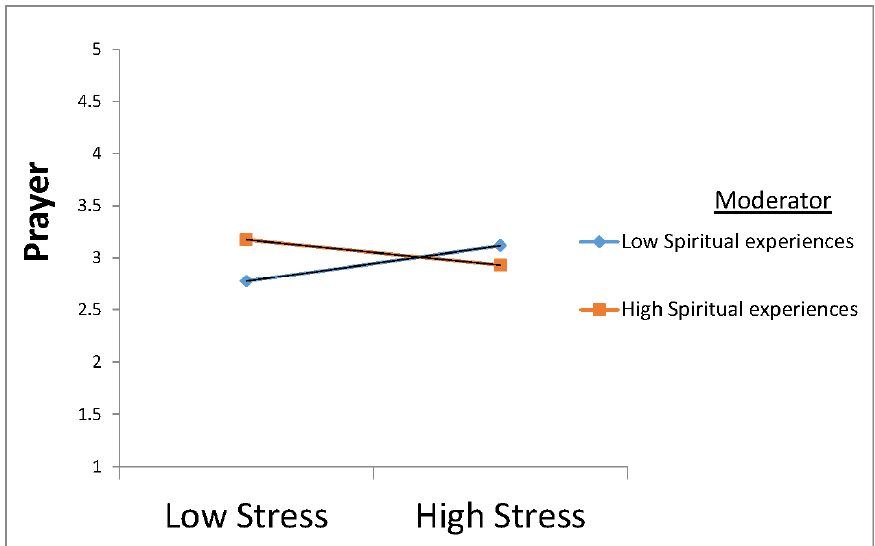
Figure 2. Moderating effect of spiritual experiences in the relationship between prayer and stress in a sample of Chilean students ( n = 177). (Source: author’s research).